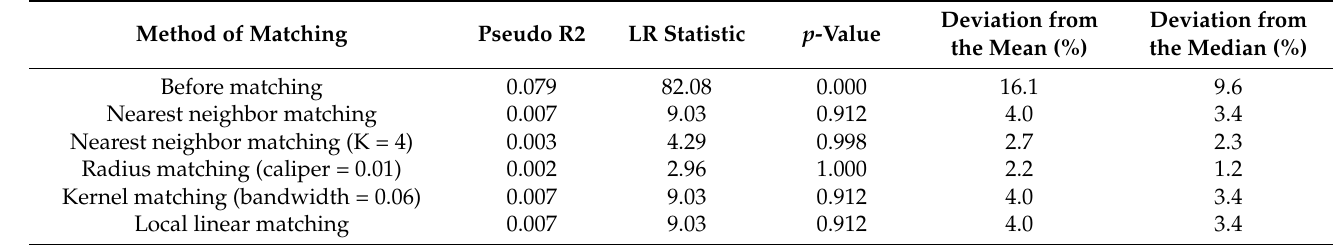
Table 9. Results of balance test of explanatory variables before and after